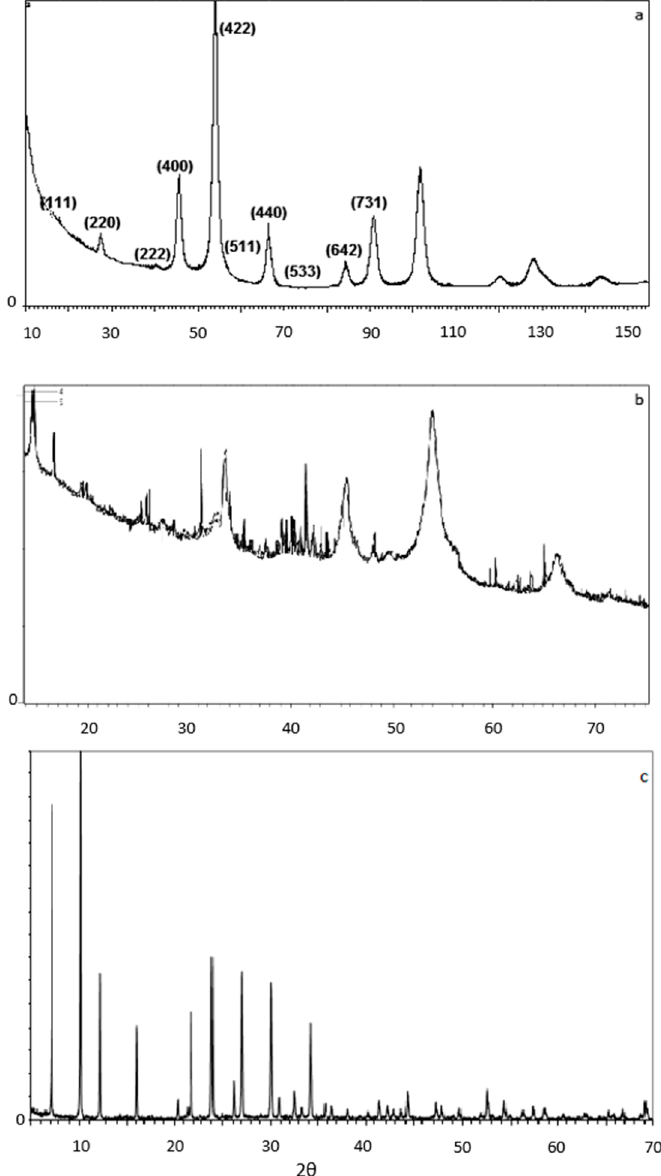
Figure 5. X-ray di ff raction (XRD) spectra for ( a ) synthetized magnetite nanoparticles, ( b ) synthetized Fe 3 O 4 / zeolite-X composite particles and ( c ) synthesized